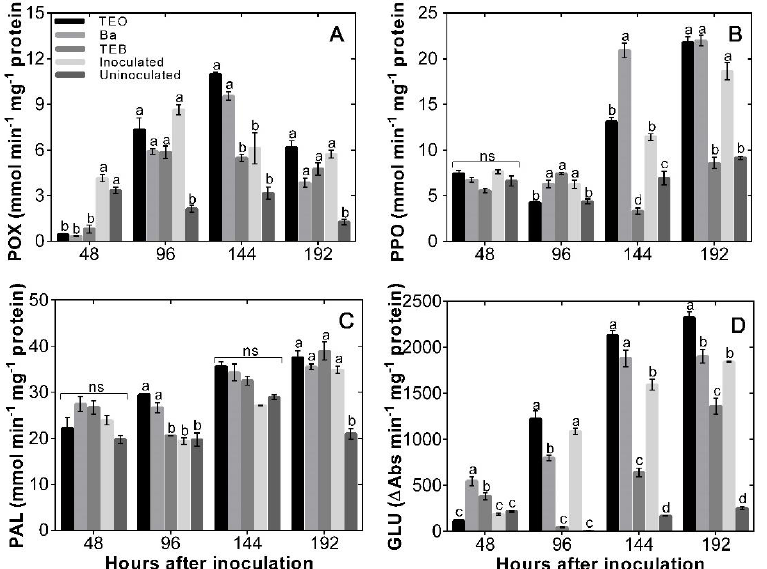
Figure 7. Pearson’s correlation between variables associated with vegetative growth, yield and epidemiological parameters (top right panel). Histograms (perpendicular centerline). Correlation fit line and data distribution (bottom left panel). Variables: SD, stem diameter; PH, plant height; PFW, plant fresh weight; PDW, plant dry weight; NL, no. of leaves; AUDPC, area under the disease progress curve; SEV, disease severity; NF, no. of fruits; APY, average plant yield; and AFW, average fruit weight. * Indicates p < 0.05, ** indicates p < 0.01, *** indicates p < 0.001.